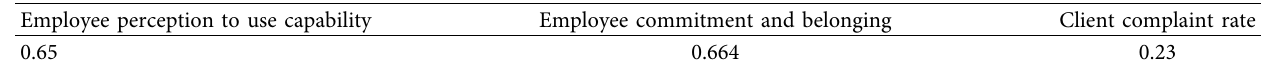
Table 7: Weights obtained from the hierarchical analysis process in the customer